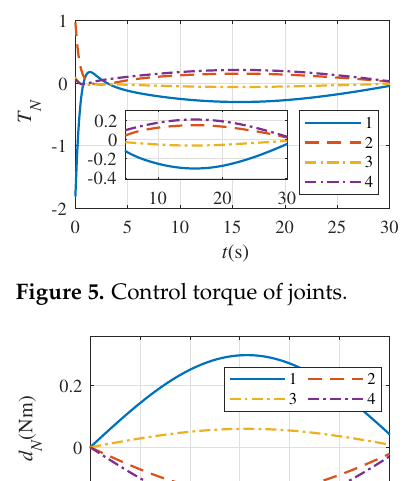
Figure 4. Tracking curve of joint angle.